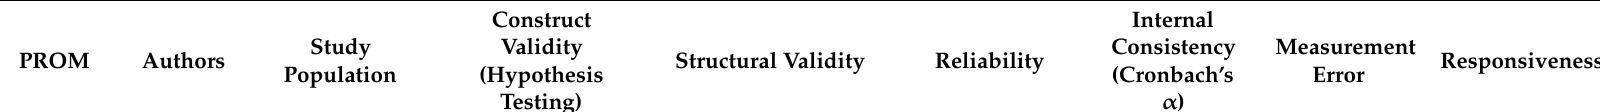
Table 10. Summary of the measurement properties of each HSQ and its